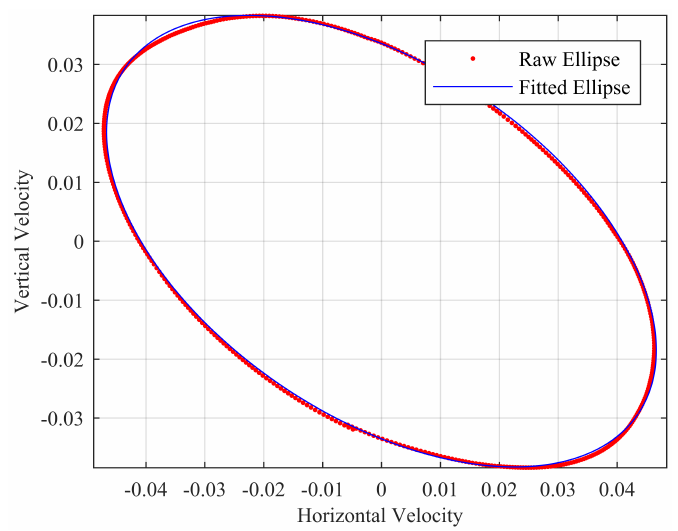
Figure 5. Orbital velocity trace fitted with an